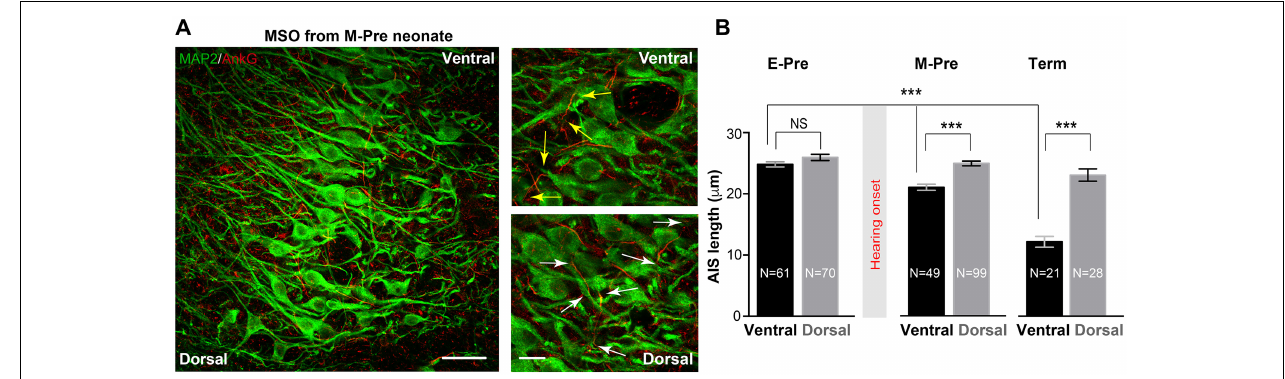
FIGURE 6 | Refinement of the axon initial segment of MSO neurons at different gestational ages of baboon neonates. (A) AnkG and MAP2 expression in ventral MSO from M-Pre neonates. The image includes 50% position (from the dorsal edge) of the MSO. Magnified images from ventral MSO and dorsal MSO immunostained with MAP2 and AnkG. Arrows indicate the length of AnkG expression. Scale = 50 µ m (left) and 20 µ m (right). (B) AIS length (AnkG) in the dorsal MSO and the ventral MSO at different GA. Hearing onset is between 67% (E-Pre) and 77% (M-Pre). Data were shown as mean ± s.e.m. *** < 0.001, one-way ANOVA and post hoc Tukey test.